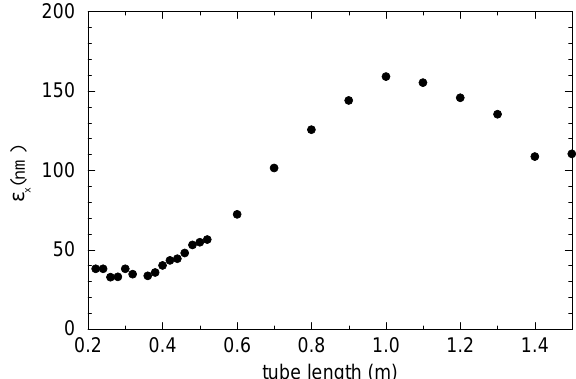
FIG. 10. Emittance degradation as a function of the tube length, where the gap is kept fixed at 1 m.